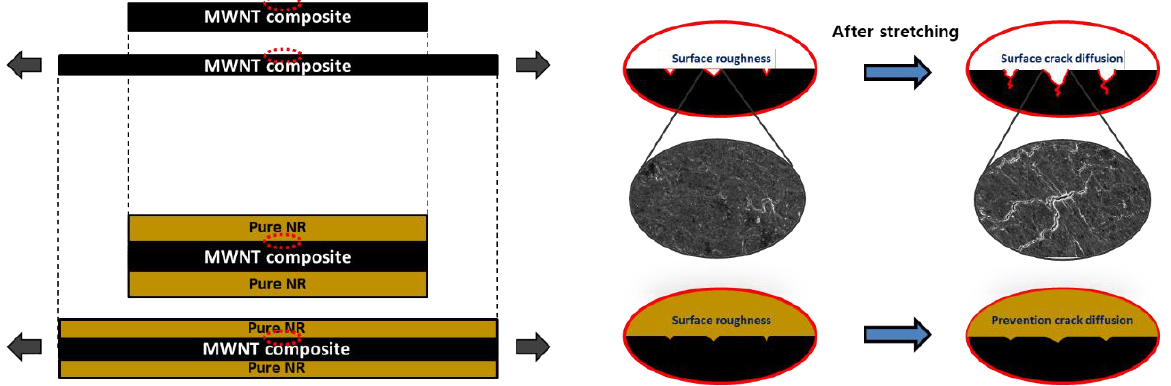
Figure 8. Schematic of the behavior of the surface crack in single- and hybrid-structured MWNT/NR nanocomposite samples under stretching.